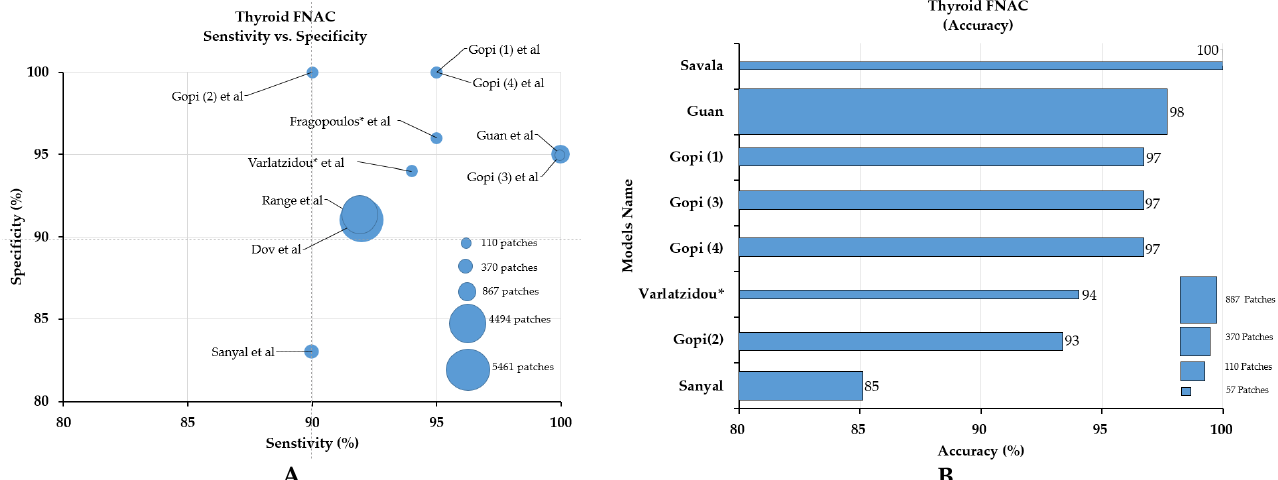
Figure 4. Comparison of sensitivity, specificity ( A ), and accuracy ( B ) of AI classification models in thyroid fine-needle aspiration cytology. The models by Gopinath (3) [36], and Guan et al. [40] showed higher sensitivity; the model by Gopinath (1) [34], Gopinath (2) [35], and Gopinath (4) [49] et al. showed higher specificity; and the model by Savala et al. [37] showed higher accuracy. * Indicates that the dataset was in nuclei form instead of patches.